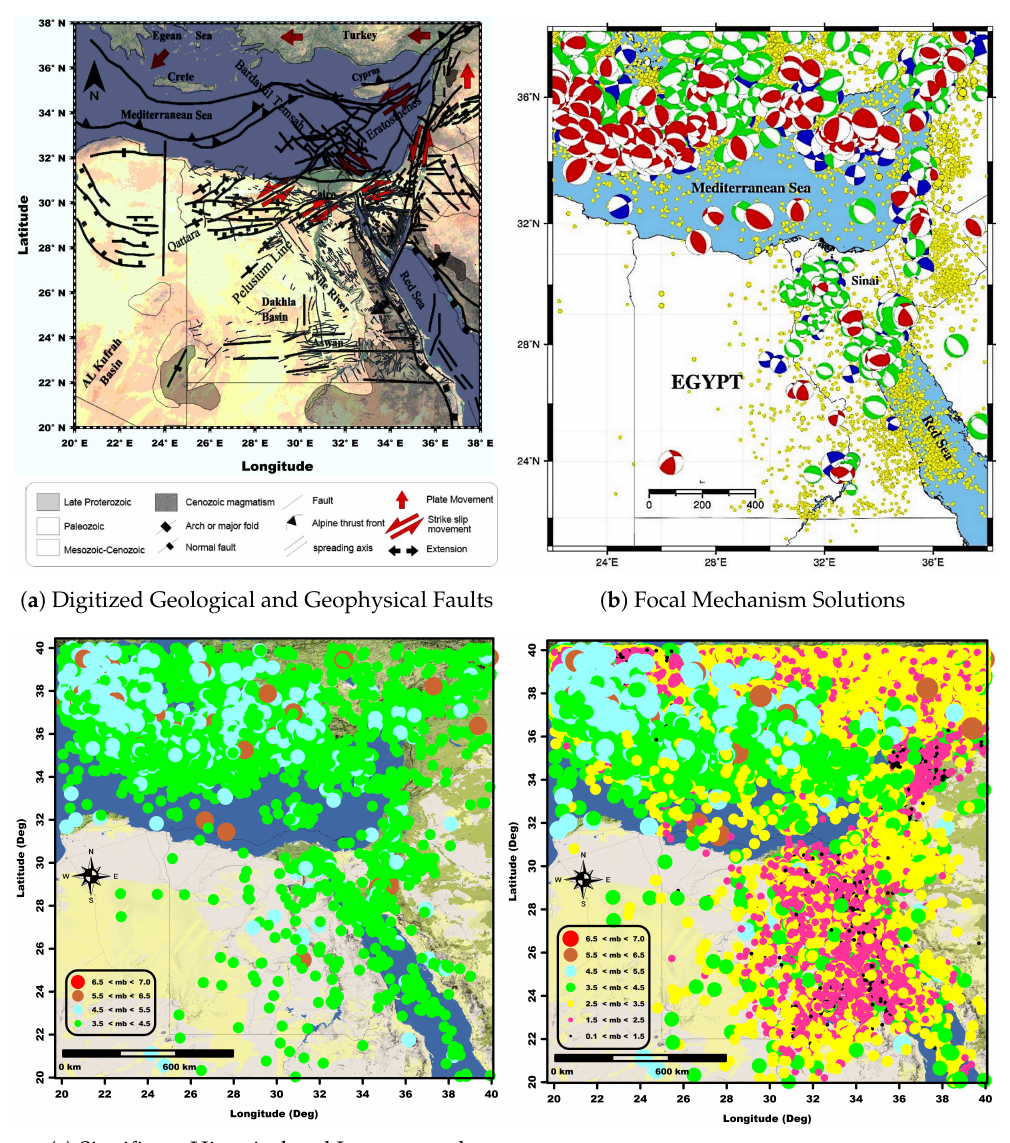
Figure 4. ( a ) Digitized surface traces of geological faults from [14,15,20,39,41,53,54,58–64]. The thin lines represent the geological identified faults and the thick lines represent the geophysical faults. ( b ) Distribution of the focal mechanism solutions in and around Egypt [65,66]. Symbols and focal sphere sizes are in proportion to the moment magnitude. Focal sphere colours refer to different fault types (blue: strike-slip; green: normal; red: reverse). ( c ) Significant historical and instrumental events have affected the area. Historical events are compiled from [67]. Dark lines are geological faults. ( d ) Compiled seismic activity catalog based on Egyptian instrumental seismicity